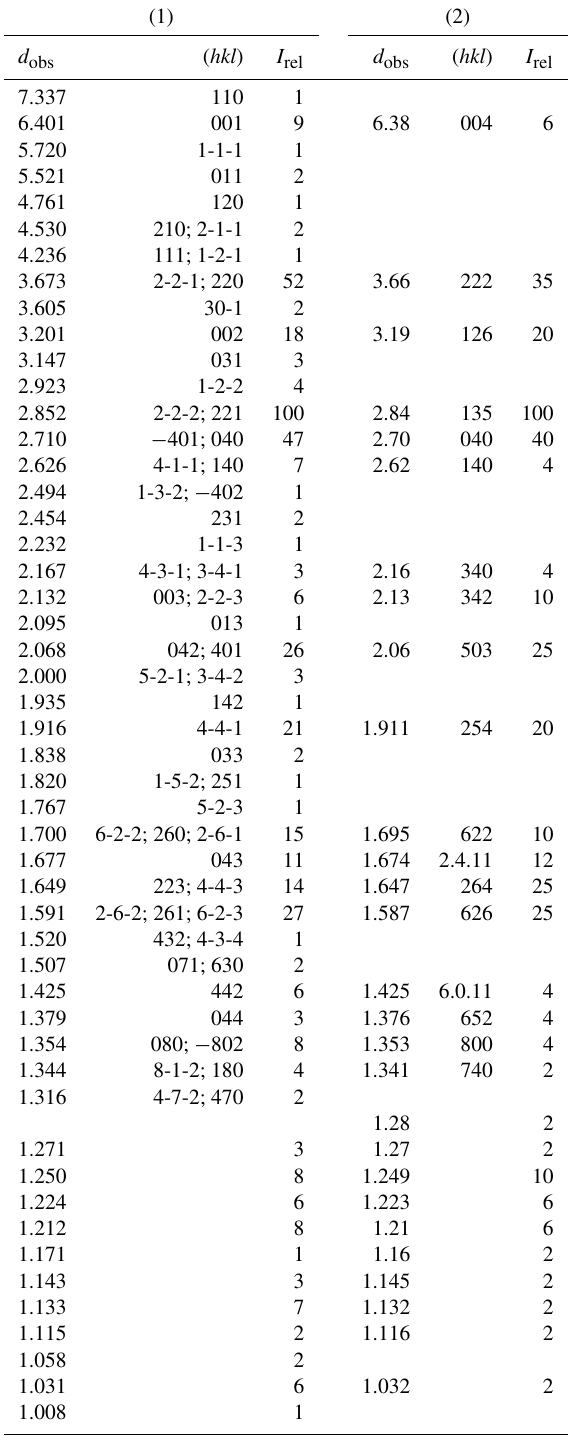
Table 3. Synchrotron X-ray powder pattern of NRM18880482 heliophyllite (1) compared with (2) X-ray diffraction data from Welin (1968).